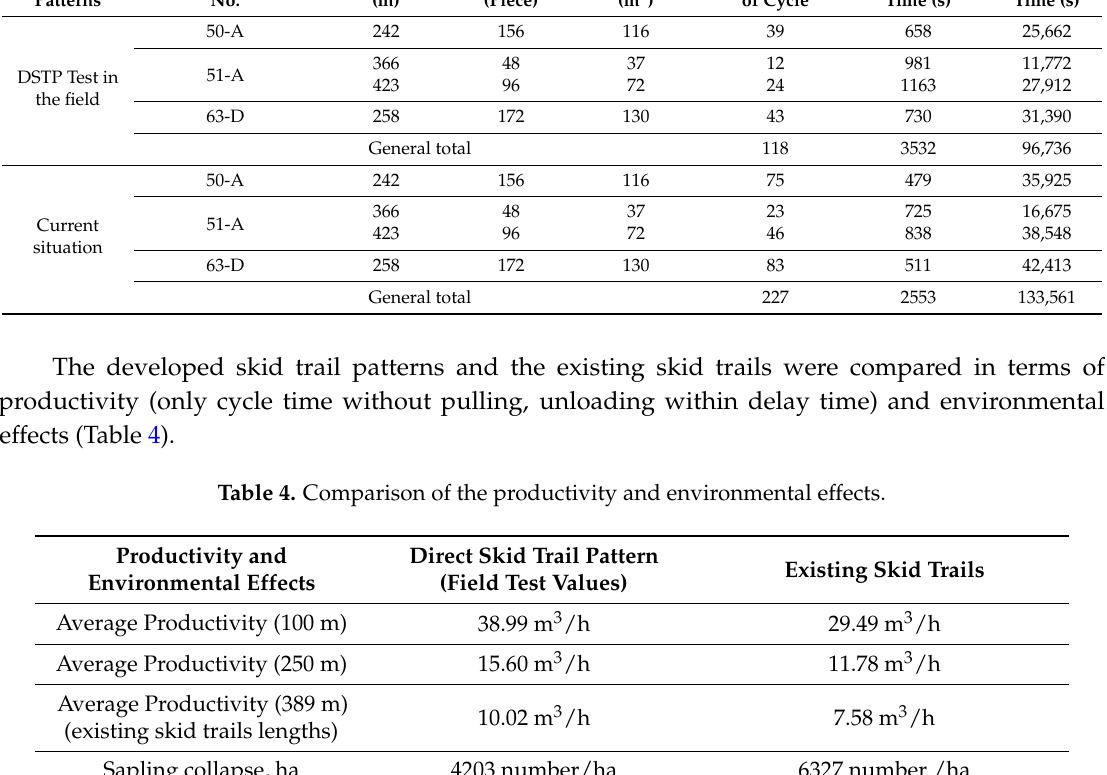
Table 3. Skidding time and operational data of skid trail patterns in the field tests. Skid Trails Patterns